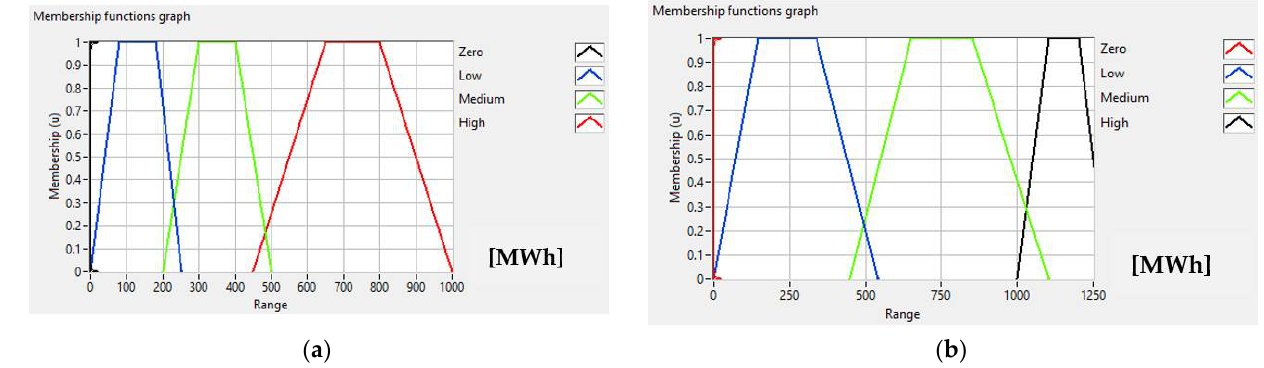
Figure 5. Membership functions of the output variables of wind power plants obtained from the defuzzification process. ( a ) Minimum energy to be generated; ( b ) maximum energy to be generated (Stage 3). X-axis range in (MWh).